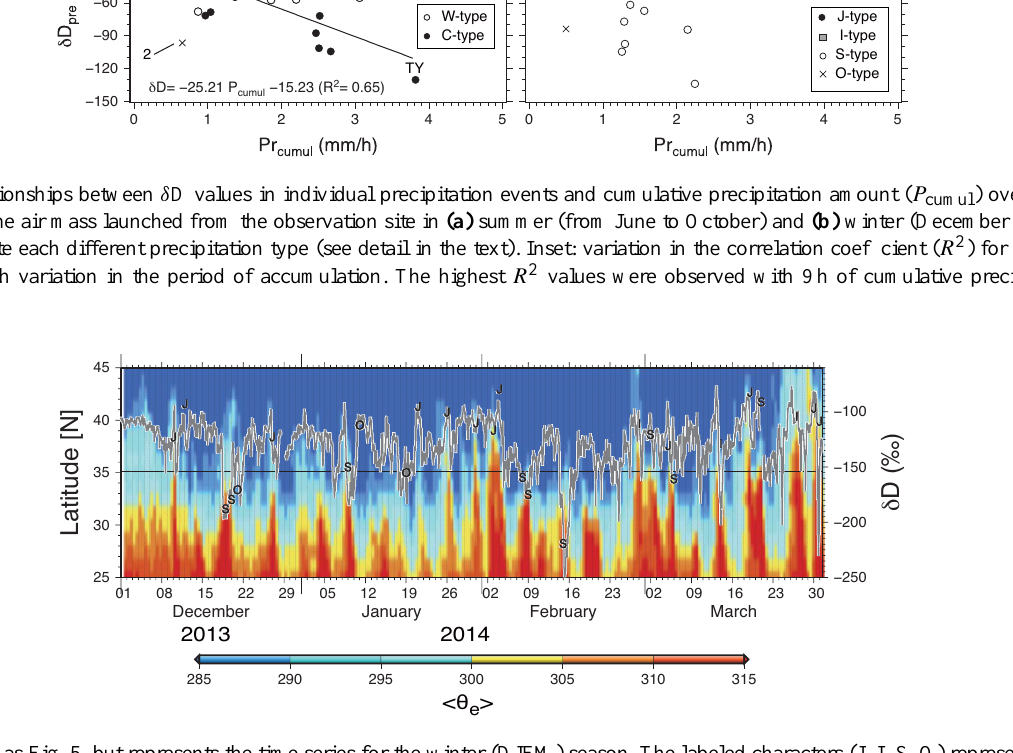
Figure 7. Same as Fig. 5, but represents the time series for the winter (DJFM) season. The labeled characters (J, I, S, O) represent the type of precipitation event as follows: J, Japan Sea-type; I, Intermediate-type; S, southern coastal-type; and O,